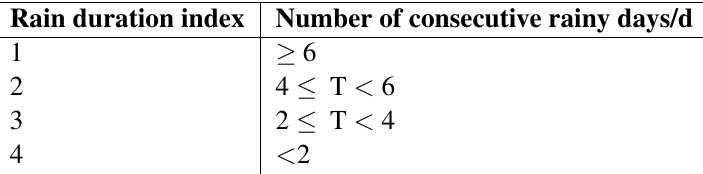
Table 2 Rainfall duration index assignment standard